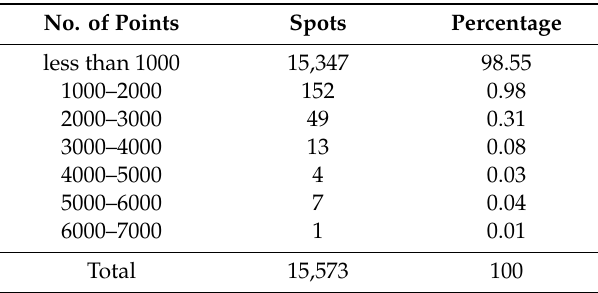
Table 4. Spot statistics with